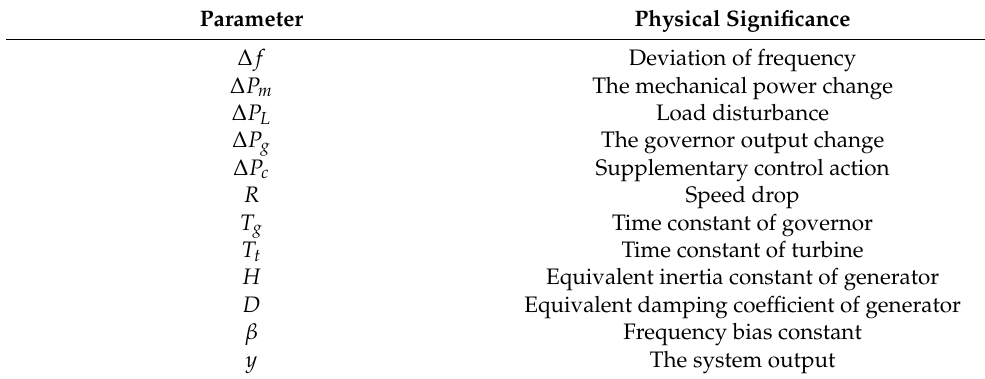
Table 1. Parameters of the power